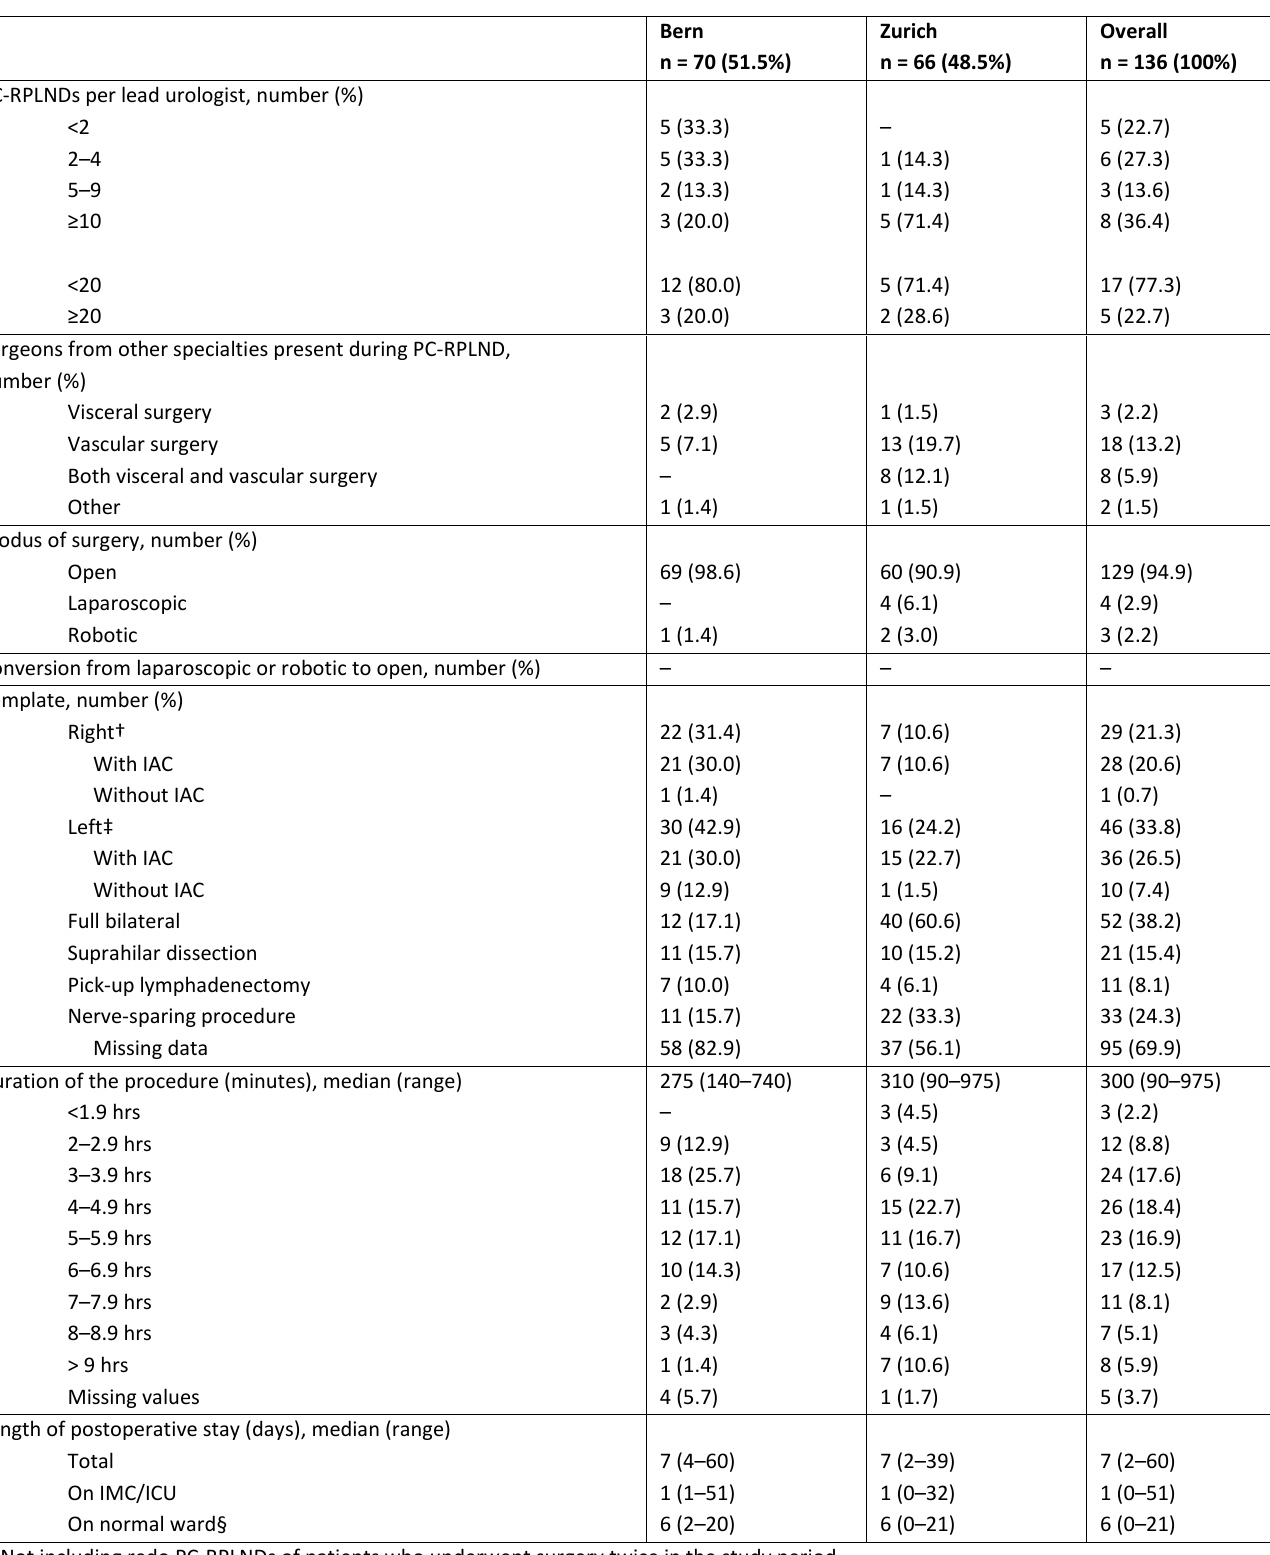
Supplementary table 3. Surgical data